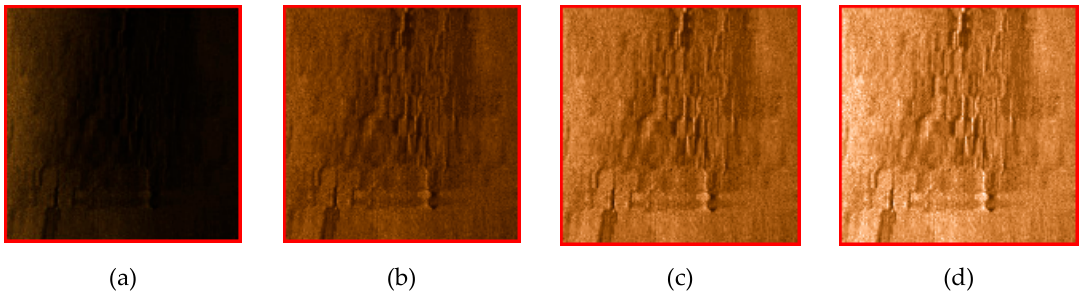
Figure 5. Local enlargement of Figure 4. (a) Original image and corrected image with (b) A = 80, (c) A = 140, and (d) A = 200.